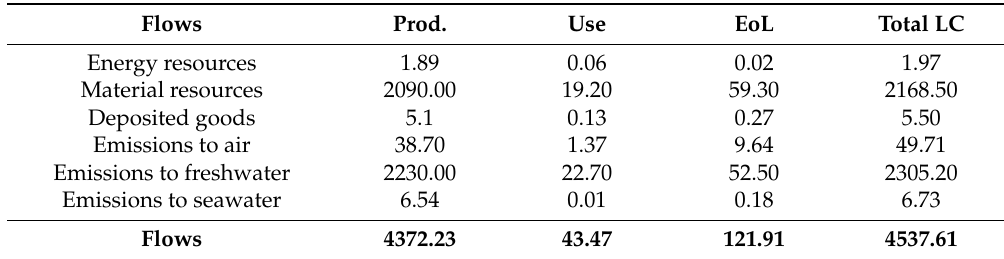
Table 3. Absolute values of resources and emissions in the life cycle stages with looping. (Functional unit: 1 kg of polypropylene product. Weighting quantity: Mass, normalization unit: kilogram. Impact assessment method: CML 2016).